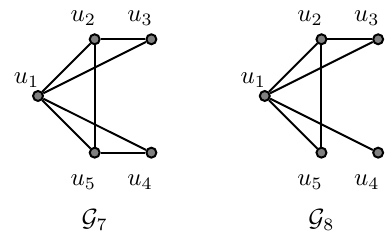
Figure 5: The graphs G